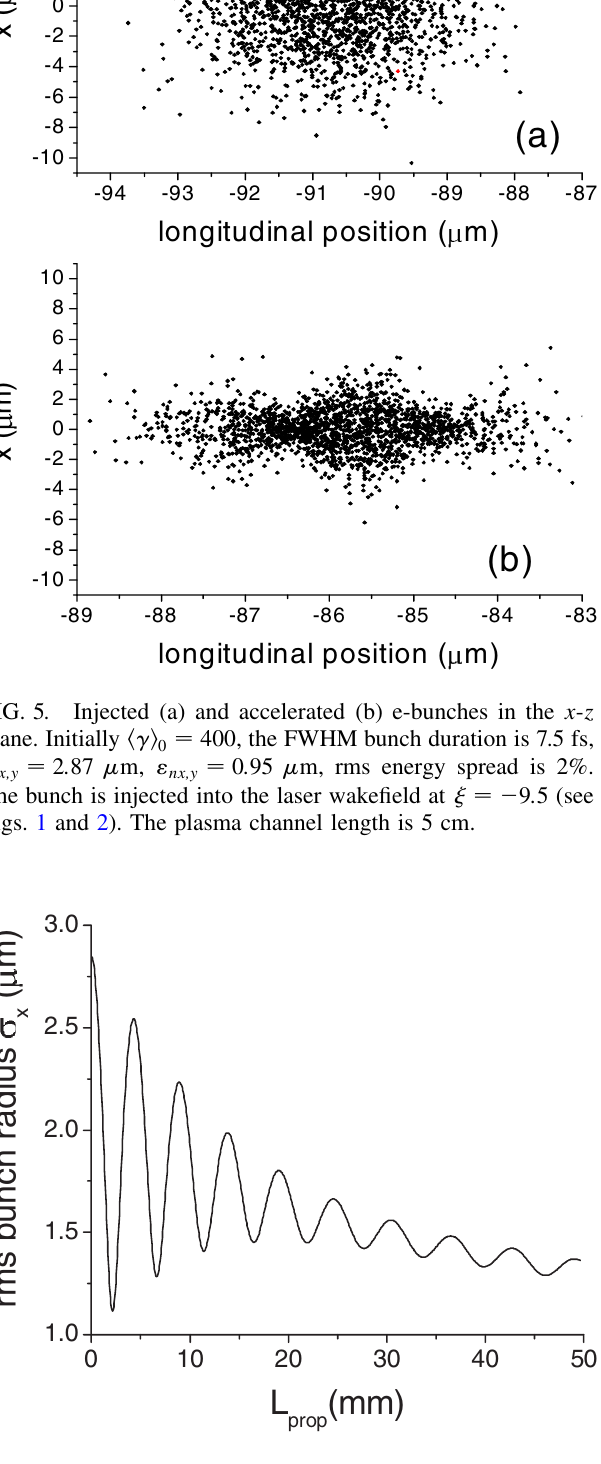
FIG. 6. Evolution of rms bunch radius during acceleration in the laser wakefield for the case simulated in Fig.